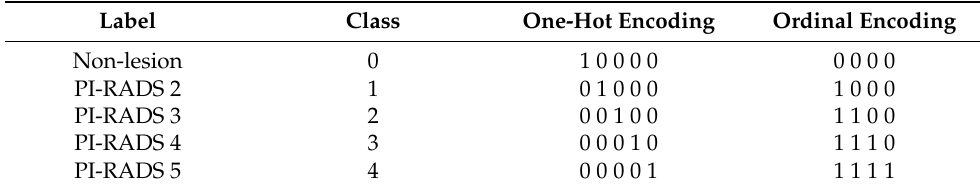
Table 1. PI-RADS category encoding for multi-class